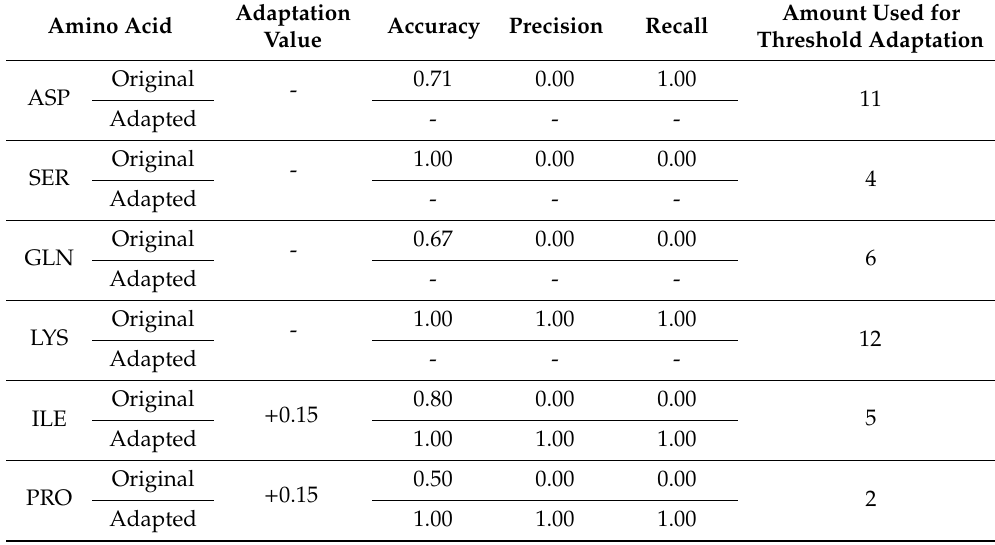
Table A3. Extremely randomized trees algorithm scores, by amino acid, in the testing set. Amino